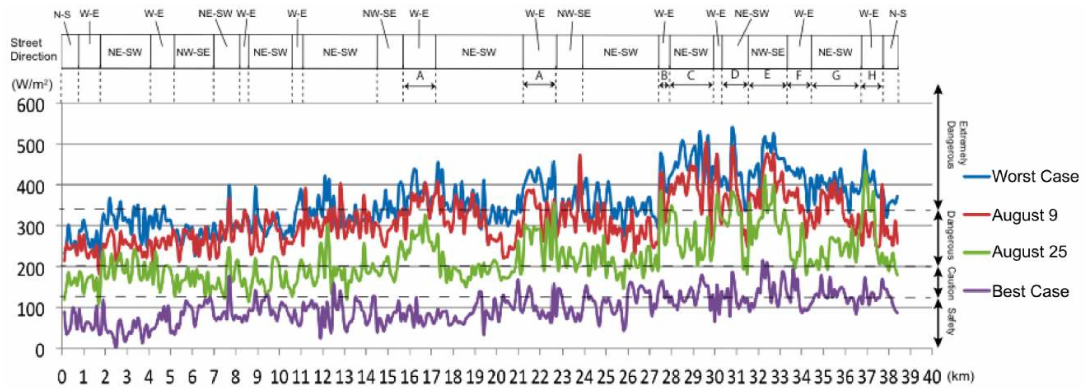
Figure 11. Graphs comparing the heat budget for each day and scenario, including street